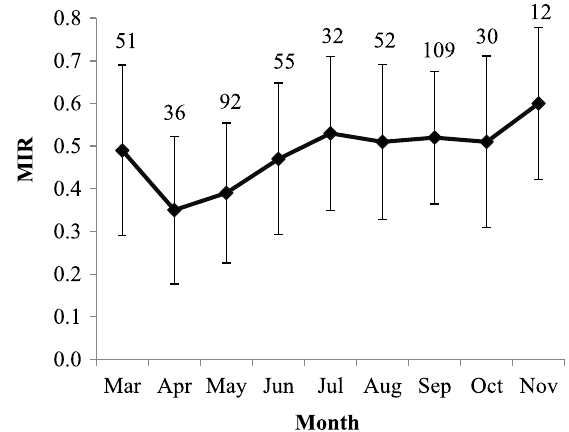
Fig. 5. Mean monthly marginal increment ratio (MIR, Error bars =SD) of Coilia brachygnathus scales. Sample sizes indicated above the data